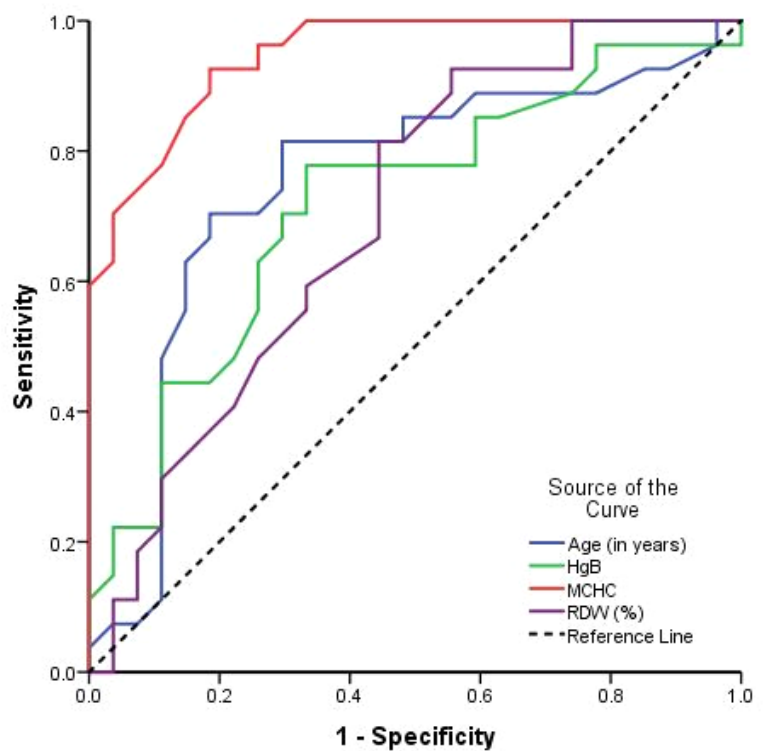
Figure 5. Predictive accuracy of blood cell indices and age for the occurrence of hernia. A receiver operating curve (ROC) with an area under a curve (AUC) was used to determine the predictive accuracy of blood cell indices for hernia and strangulation. HgB: Haemoglobin; MCHC: Mean cell haemoglobin concentration; RBC: Red blood cell; RDW: Red cell distribution width. p≤0.05 was considered significant.